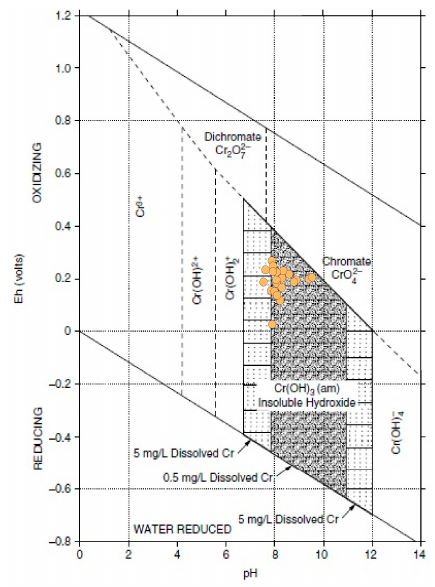
Figure 4. In situ redox conditions in the study area.